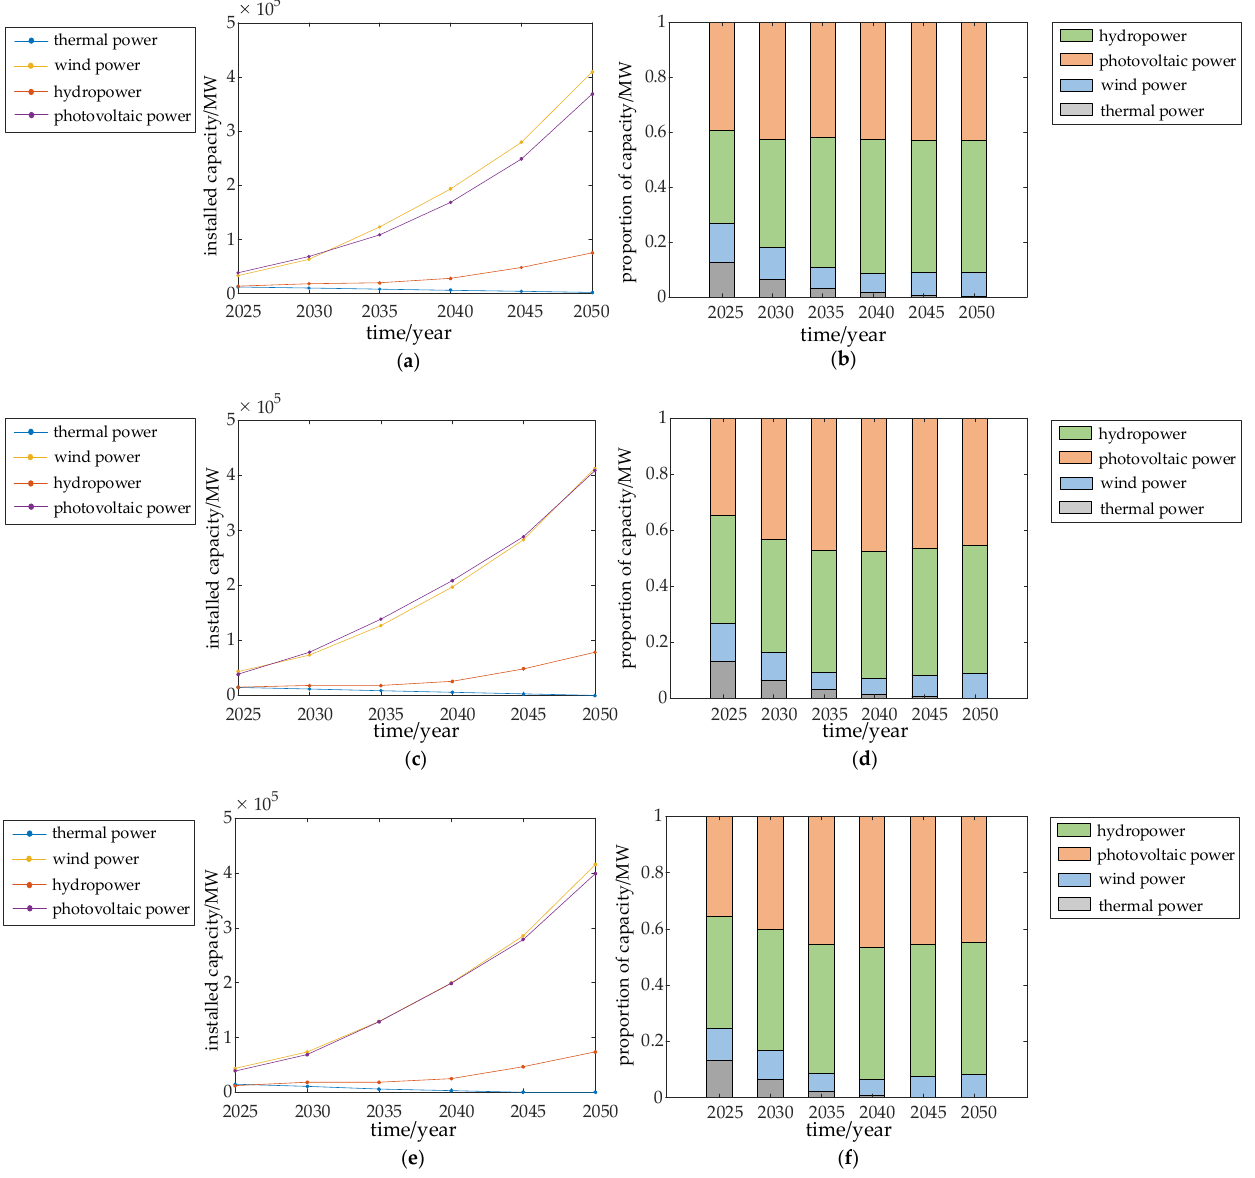
Figure 10. The installed capacity of and share of the power sources. ( a , b ) scenario 1; ( c , d ) scenario 2; ( e , f ) scenario 3.